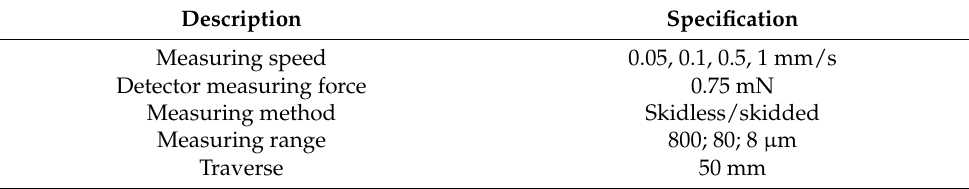
Table 9. Specifications of the surface roughness measuring instrument used in the